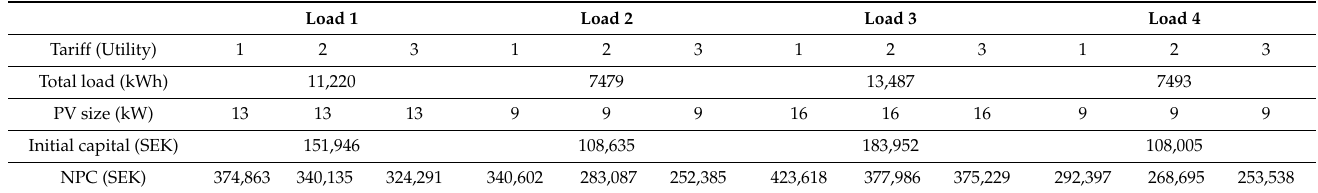
Table 3. Results of pre-sizing grid-connected PV systems without batteries (GRID-PV-ONLY).